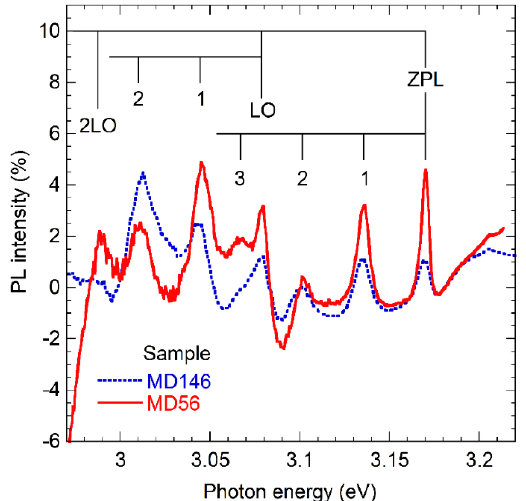
Figure 4. PL spectra from two GaN:C samples (MD56 and MD146) after subtracting the dependence calculated using Equation (1) with parameters in Figure 1 for the BL C band. P exc = 100 W/cm 2 . Two LO phonon replicas of the ZPL line at distances integer of ħΩ LO = 91.2 meV and several pseudo-local phonon replicas (labeled with n = 1, 2 and 3) with ħΩ 1 = 34.3 meV are indicated.